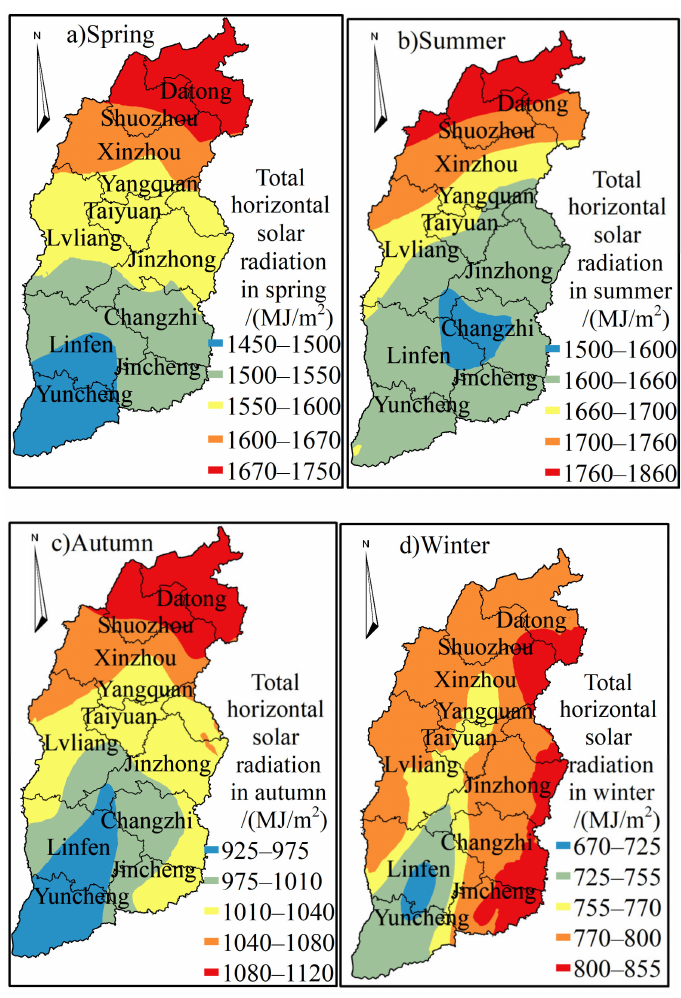
Figure 4. Spatial distribution of total horizontal solar radiation in Shanxi